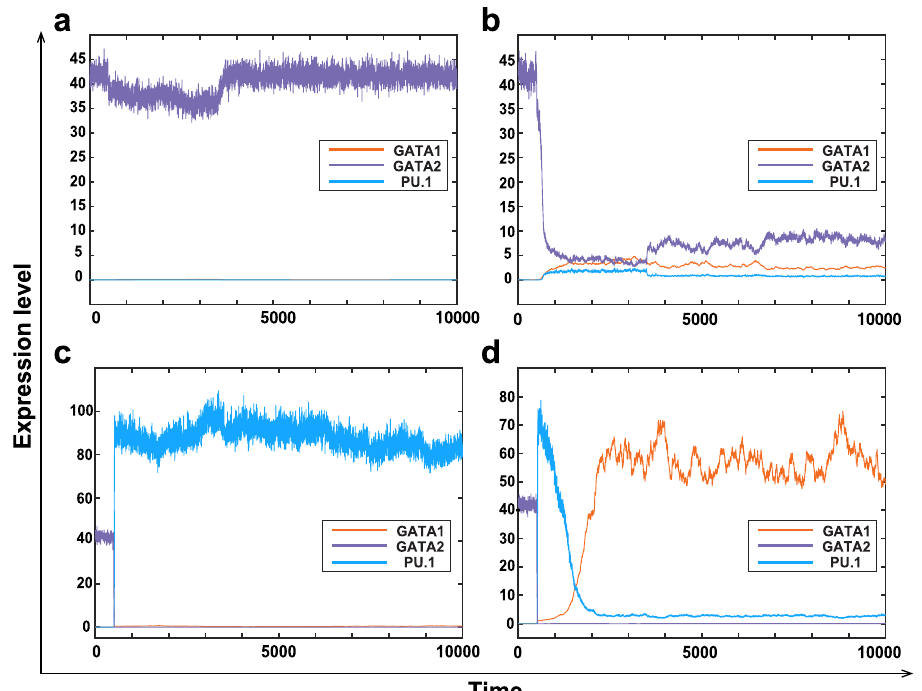
Fig. 4 Stochastic simulations showing four stable states that correspond to the experimentally observed four different states. a Simulation of unsuccessful GATA switching that makes the cell stay at the HSC state, which is the G2H state. b Simulation of unsuccessful GATA switching but the cell enters the state with low expression of all three genes, which is the LES CMP state. c Simulation of successful switching that leads to the GMP state with high expression levels of PU.1 , which is the P1H state. d Simulation of successful switching that leads to the MEP state with high expression levels of GATA1 , which is the G1H